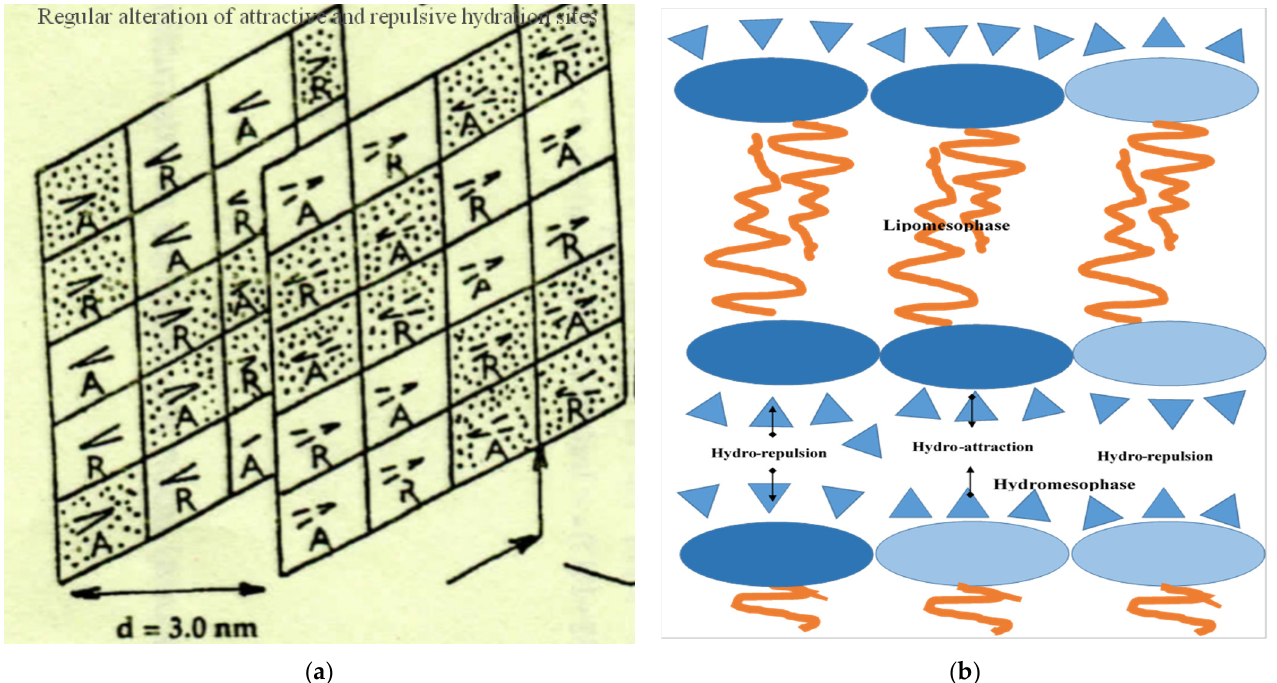
Figure 1. Schematic representation of regular alternation of the attractive (A) and repulsive (R) hydration forces during mutual interaction of two micro-planes with mosaic types of organization of the hydrated sites. The symbols “ ∆ ” denominate water molecule O < HH . Taken from Ref. [26]. ( a ) Mosaic alternation of attractive/repulsive hydration forces; ( b ) Stylized illustration of mosaic alternation of hydration forces. Dark and pale blue shades represent the hydrophilic groups of amphiphilic molecules with prevailing proton donor and proton acceptor activities towards water molecules, respectively.